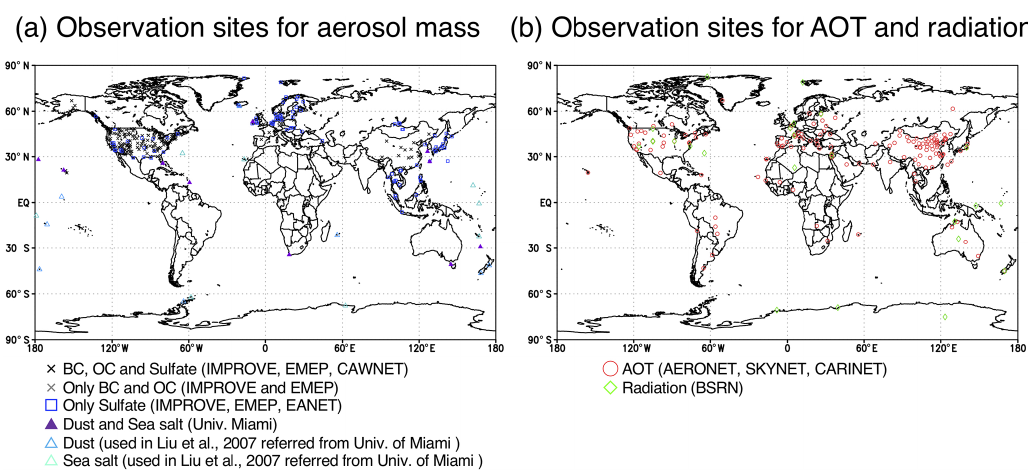
Figure 1. Global distribution of observation sites used in the model evaluation. Detailed information on these sites is provided in Tables S1– S4 in the